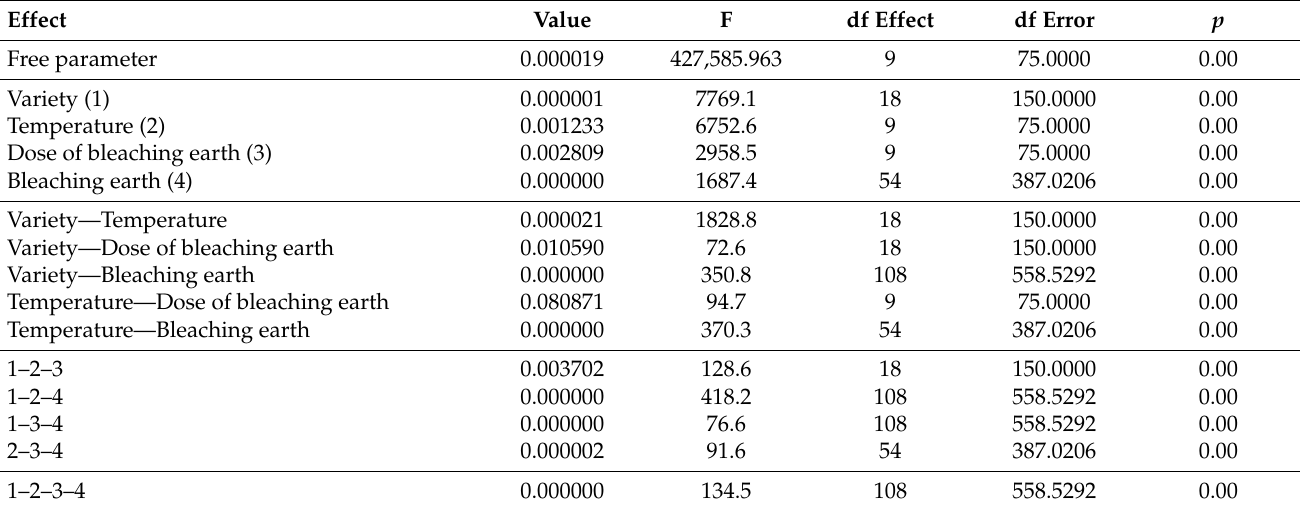
Table 1. The results of the MANOVA multivariate analysis of variance test for phytosterols ’ analysis (Wilks test; p < 0.05).